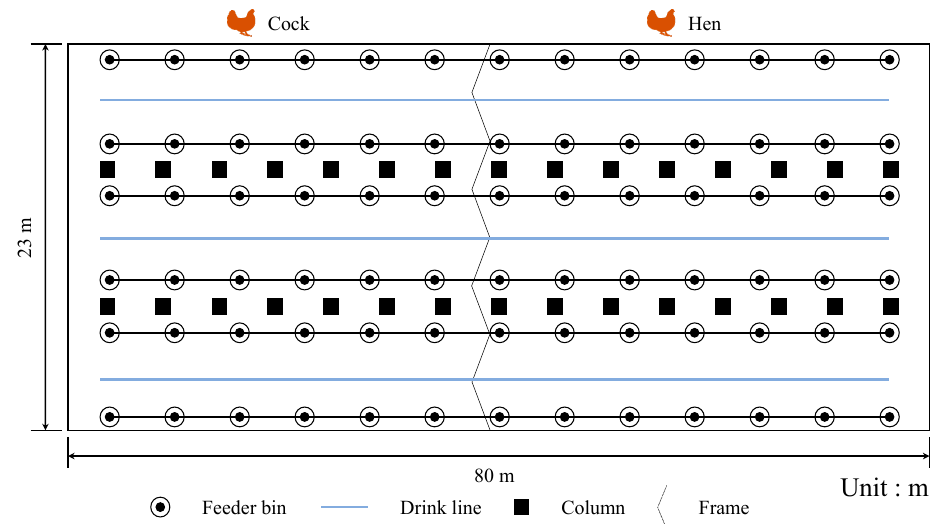
Figure 12. A schematic of the test environment. Black circles indicate feeder bins. Blue lines indicate drink lines. Black blocks indicate columns. Cocks and hens were separated by frames. The test environment had a length of 80 m in the X-direction and 23 m in the Y-direction.